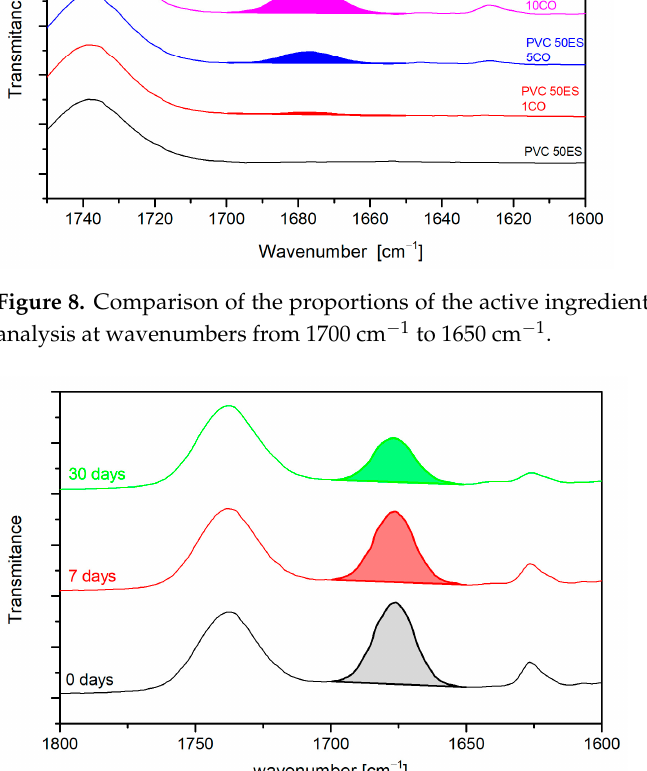
Figure 8. Comparison of the proportions of the active ingredient in materials based on band area analysis at wavenumbers from 1700 cm − 1 to 1650 cm − 1 .